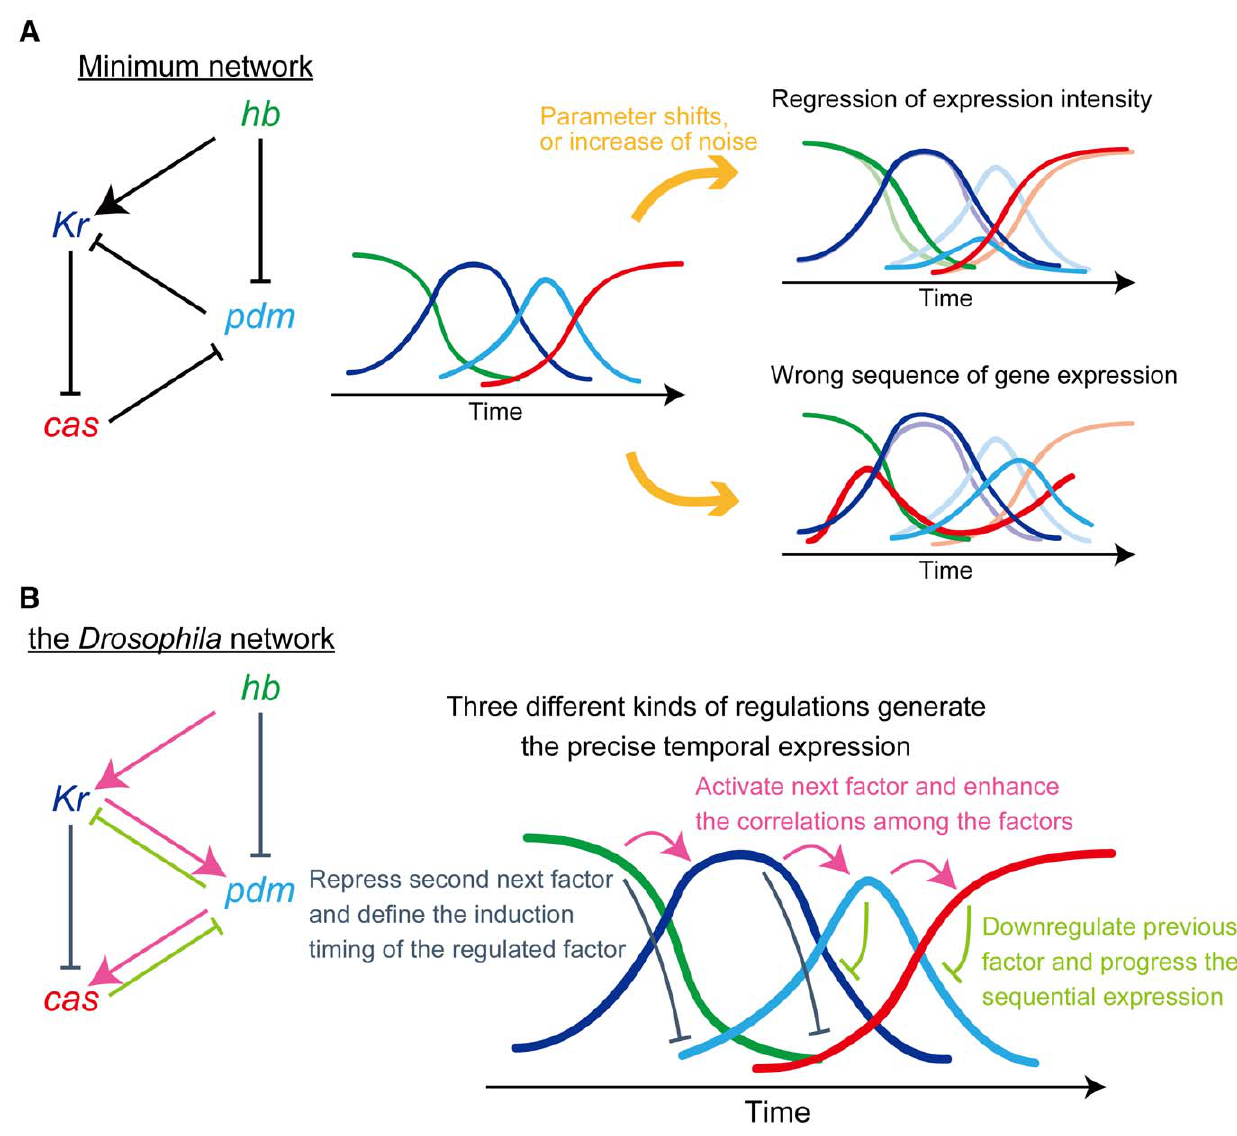
Figure 9. Regulatory module for precise sequential expression. The regulatory interactions and schematic expression profiles of the networks. ( A ) Regulatory interactions of the minimum network for sequential expression (left). This network reproduces the sequential expression under appropriate conditions (middle). However, the parameter variations from the appropriate values and the increase of noise could easily alter the expression profiles (right). ( B ) Regulatory interactions of the Drosophila network (left). Three types of regulations in this network enable the temporal expression in the precise order.